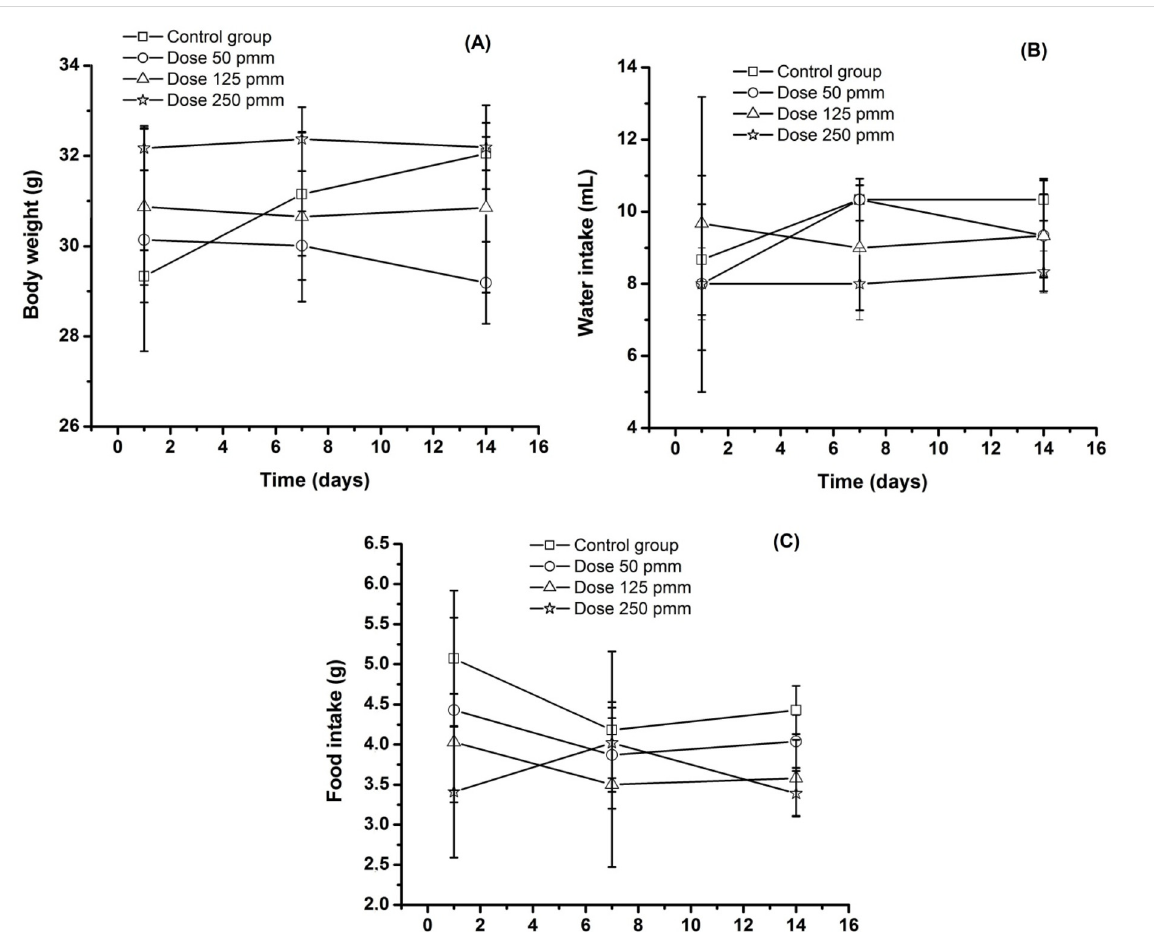
Fig 5. Analysis of body weight (A), water (B) and food intake (C) variation in mice treated with optimized P . emarginatus